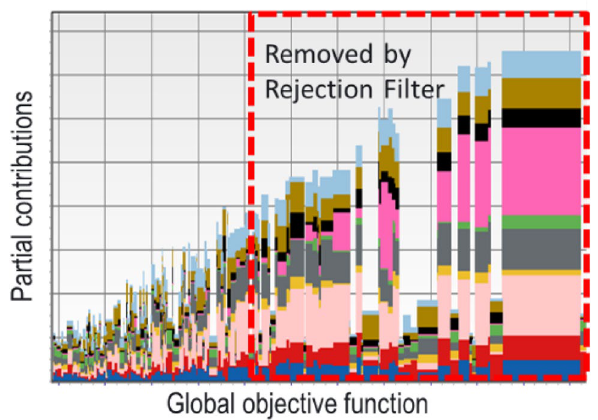
Fig. 11 Stacked plot showing partial objective contributions (indi‑ vidual rate and pressure mismatch values) against the global objective function value. The rejection filter is applied to remove cases with a poor history matching quality (red rectangle)